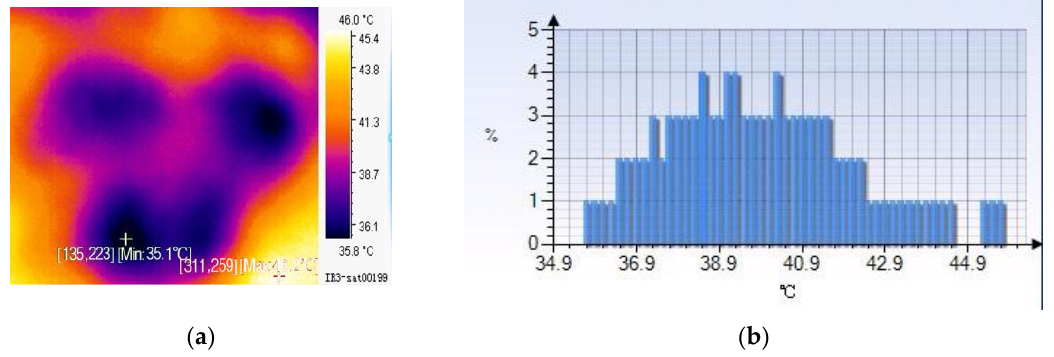
Figure 8. Infrared imaging and temperature distribution after irrigation at 10:50 a.m., ( a ) Infrared imaging; ( b ) Temperature distribution diagram.